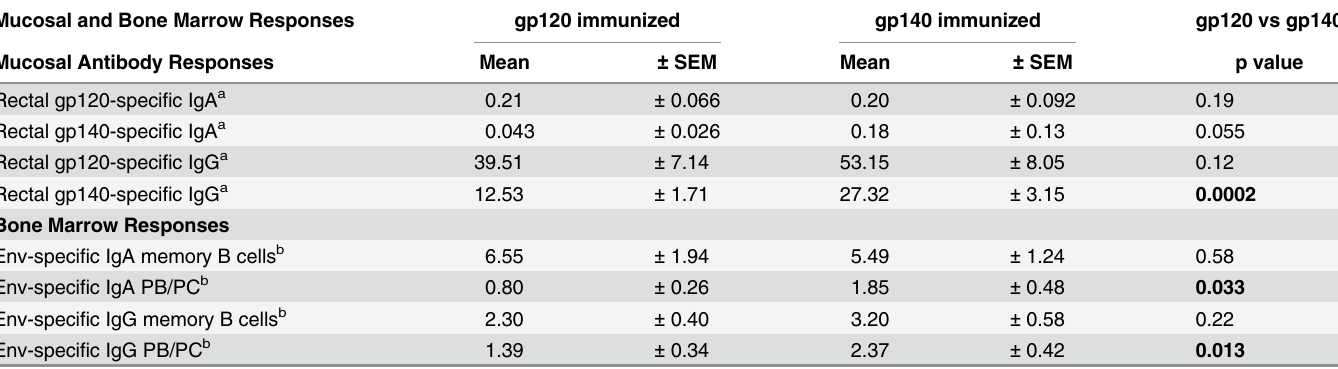
Table 2. Comparative immunogenicity of monomeric gp120 and oligomeric gp140: mucosal and bone marrow responses. Mucosal and Bone Marrow